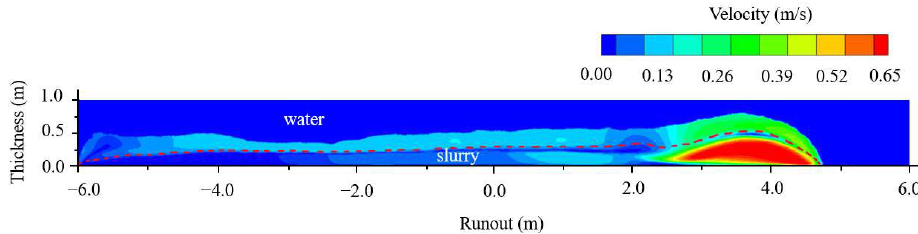
Figure 5. Changes in the velocity and run-out distance as a function of time during the run-out process.